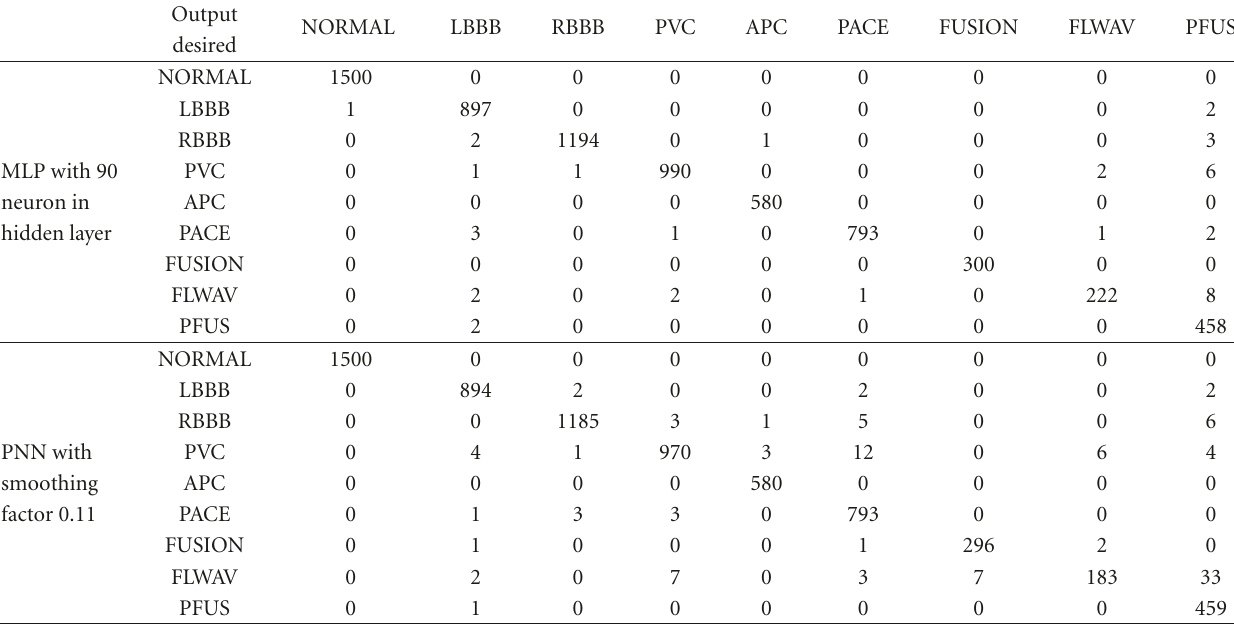
Table 2: Classification results of the proposed scheme with MLP and PNN.